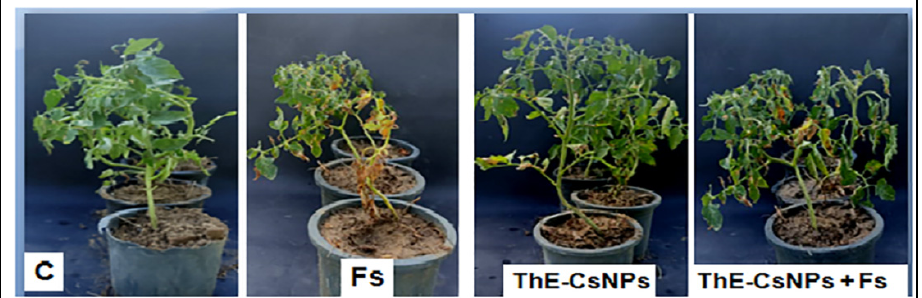
Figure 3. Effect of ThE-CsNPs (1%) on S. lycopersicum seedling growth under fusarium root rot disease (20 DAF).